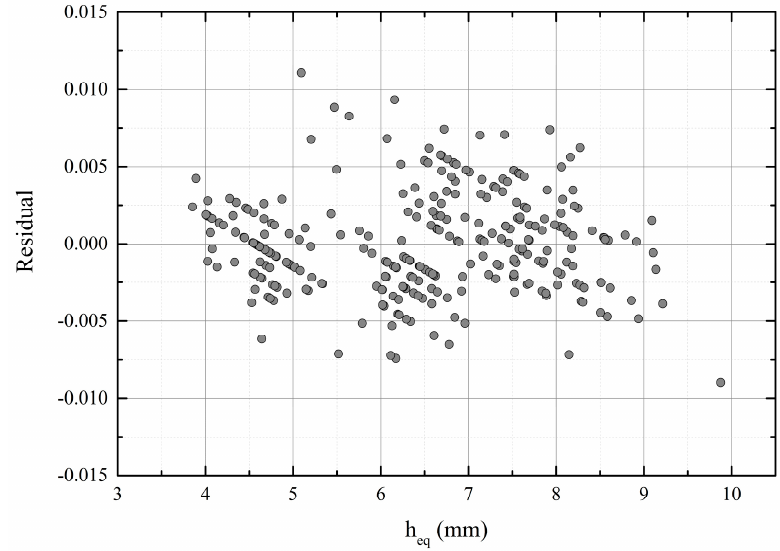
Figure 6. Residual plot for linear fit.